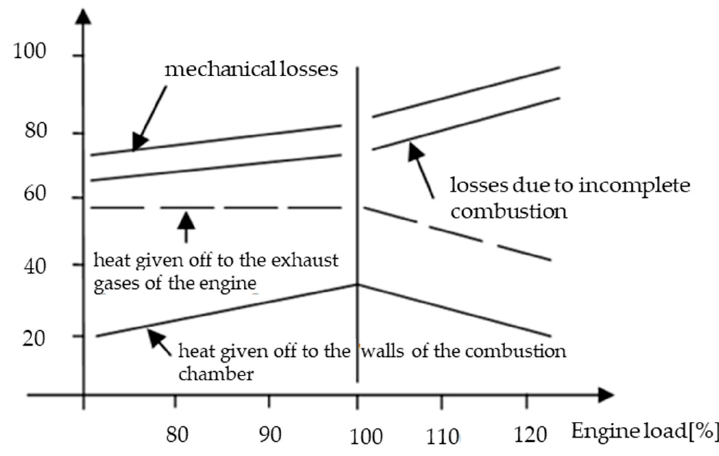
Figure 10. Distribution of energy available in the combustion chamber of the engine by burning fuel.